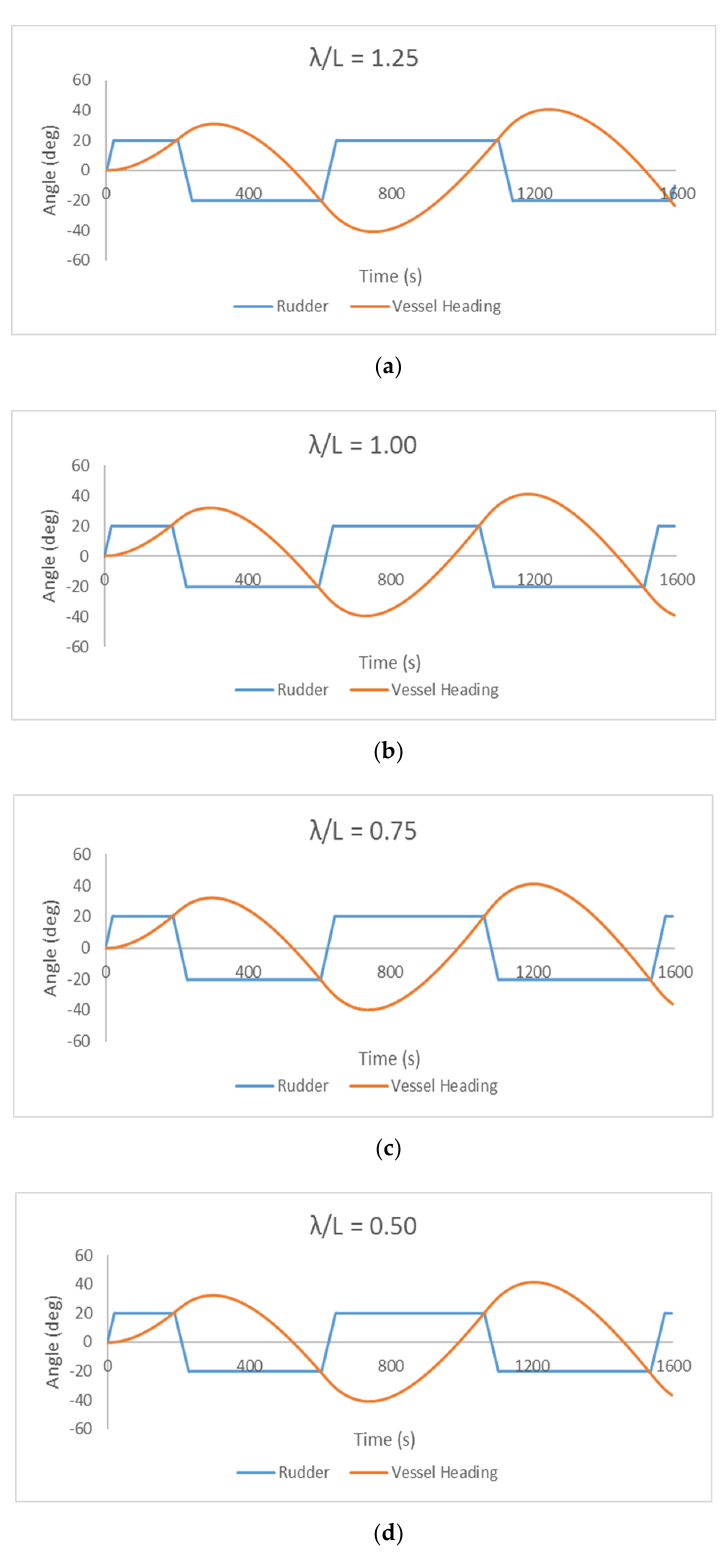
Figure 7. KVLCC’s 20/20 (starboard-side) Zig-Zag tests in regular waves with 180 deg at t = 0 and four different ratios between wave length and vessel length λ : ( a ) λ = 1.25; ( b ) λ = 1; ( c ) λ = 0.75; ( d ) λ = 0.5.